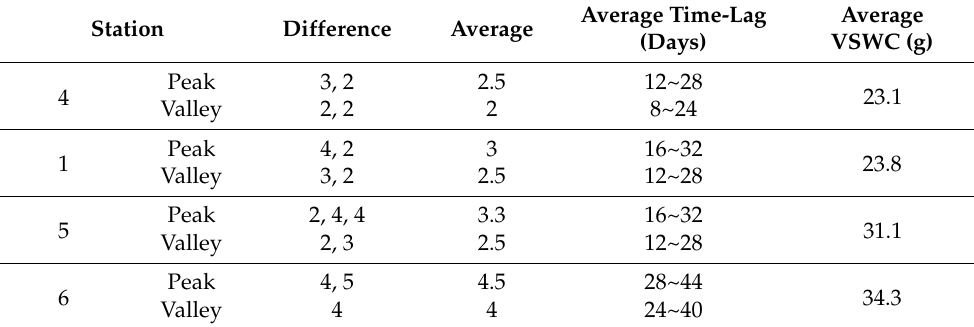
Table 4. Statistics of difference between peak/valley of forest.